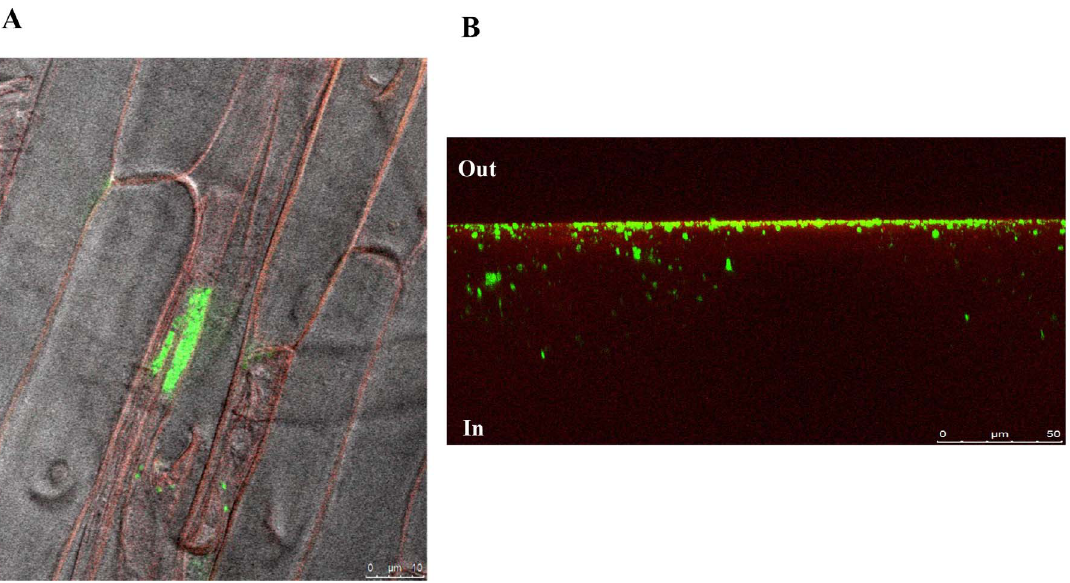
Figure 5. Colonization of rice roots by Azoarcus sp. CIB observed by confocal microscopy. Confocal images of rice roots after seven days colonization with Azoarcus sp. CIB (pSEVA23GFP) cells. (A) Bacteria are observed as single cells or as clusters of cells attached to the inner intercellular space of the exodermis. (B) XYZ projection of bacterial cells distributed on the inner part (In) or the surface (Out) of the rice root.